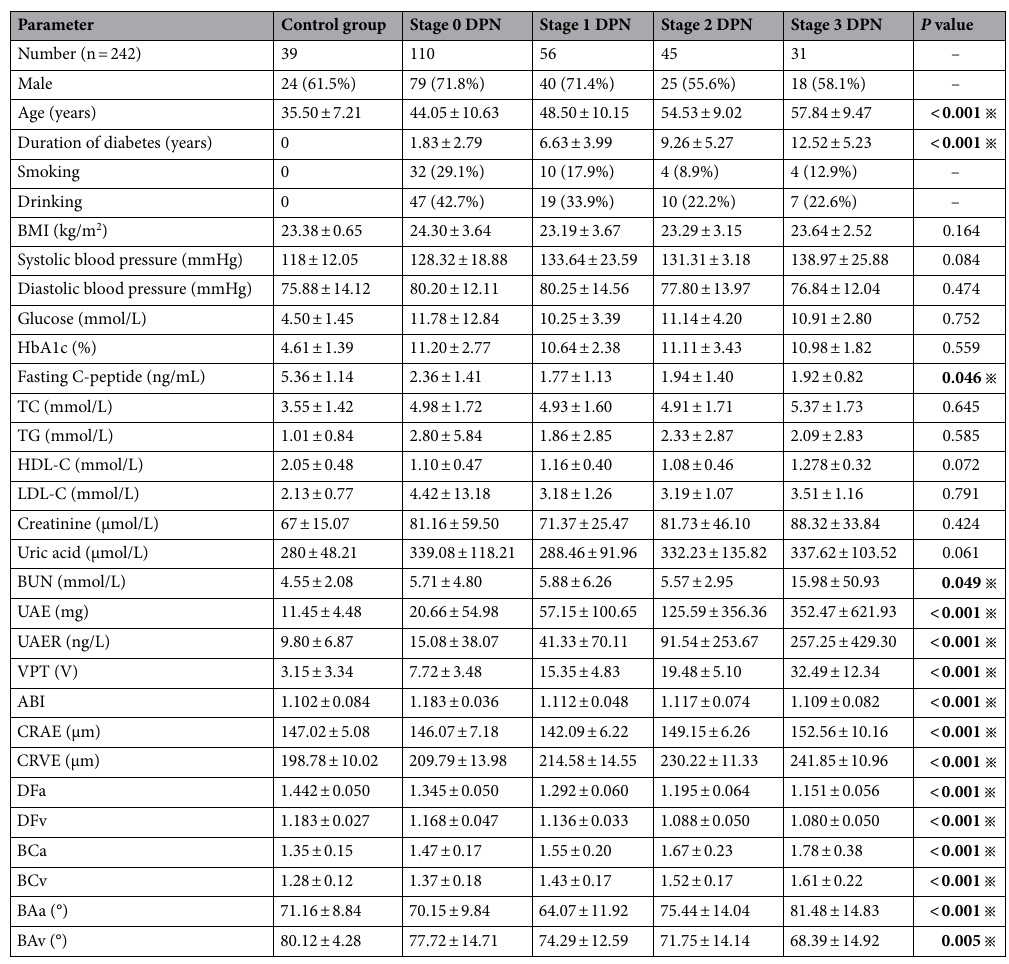
Table 1. General characteristics of diabetic patients disaggregated by stage of DPN. ANOVA, P < 0.05, statistically significant. DPN diabetic peripheral neuropathy, BMI body mass index, HbA1c glycosylated hemoglobin, TC total cholesterol, TG triglycerides, LDL-C low-density lipoprotein cholesterol, HDL-C high-density lipoprotein cholesterol, BUN blood urea nitrogen, UAE 24-h urinary protein quantity, BCa Branching coefficient arterioles, BAv Branching angle veins, BCv Branching coefficient veins, DFa Fractal dimension arterioles, DFv Fractal dimension